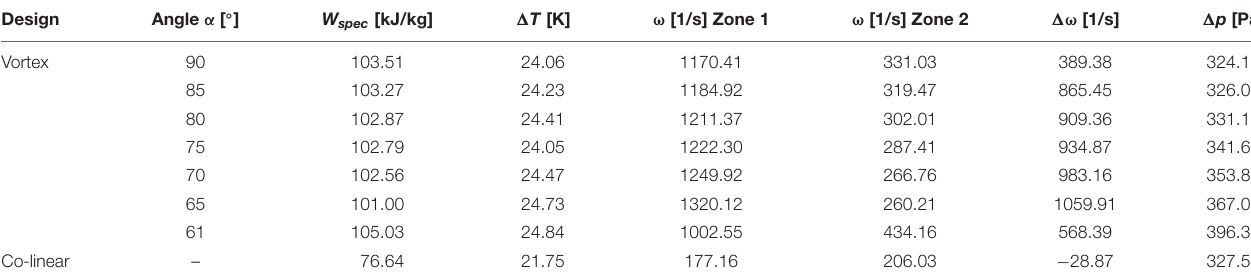
FIGURE 4 | Comparison of the co-linear (left) and the vortex (right, α = 61 ◦ ) treatment chambers, including velocity streamlines (A) with colors indicating the fluid velocity, temperature distribution (B) , as well as electric field strength (C) . Assumed processing conditions: ˙ m = 10 . 2 kg / h, T in = 20 ◦ C, E avg = 32 kV / cm, f p = 105 Hz, τ p = 3 µ s. Note that the scale on the left and right side of the figure is different, as indicated by the scale bar at the bottom. TABLE 5 | Characteristics of the flow and treatment conditions in the two different treatment chambers.